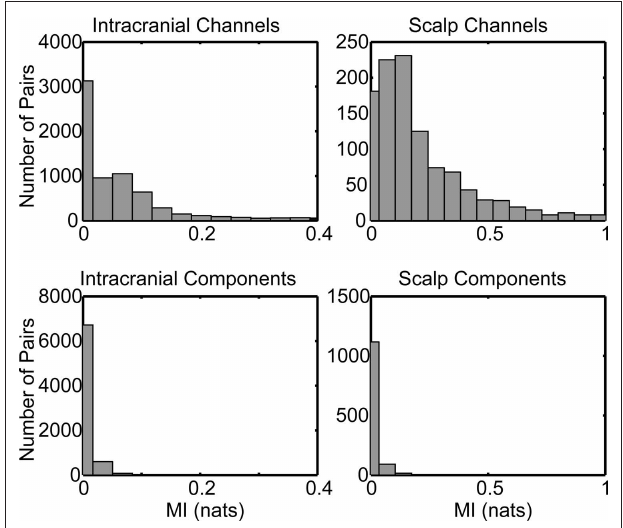
FIGurE 3 | reduction in pair-wise mutual information of independent components as compared to channels. Histograms of normalized pair-wise mutual information between channels (top row) and between independent components (bottom row) returned from ICA performed on intracranial data (left) and on scalp EEG (right). As expected, the pair-wise mutual information of independent components is greatly reduced as compared to the pair-wise mutual information of channel recordings. The plot combines results from the recordings of four patients. Nats are the units of mutual information using the natural logarithm.